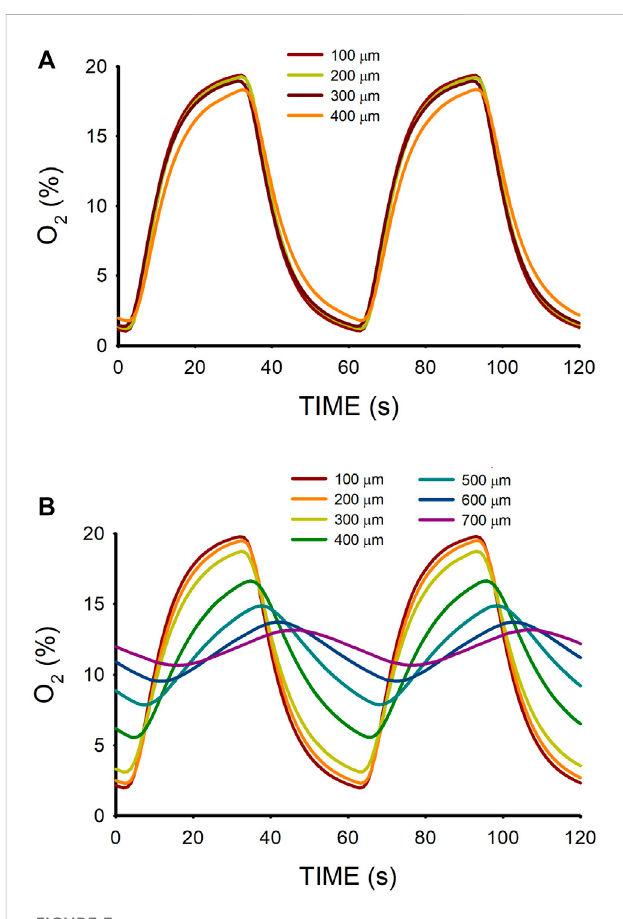
FIGURE 3 (A) Oxygen concentration measured at different positions ( z ; Figure 2A) within a lung extracellular matrix hydrogel of thickness W = 500 μ m when the intermittent air circulating beneath the membrane was20%O 2 for30 s0%O 2 for30 s. (B) Sameforhydrogelthickness W = 800 μ